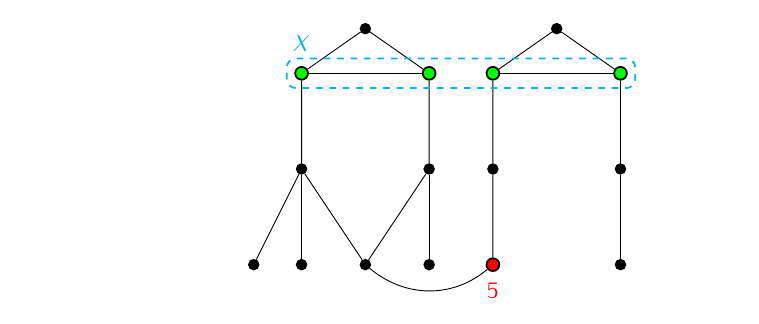
Figure 4. A counterexample to the converse of Corollary